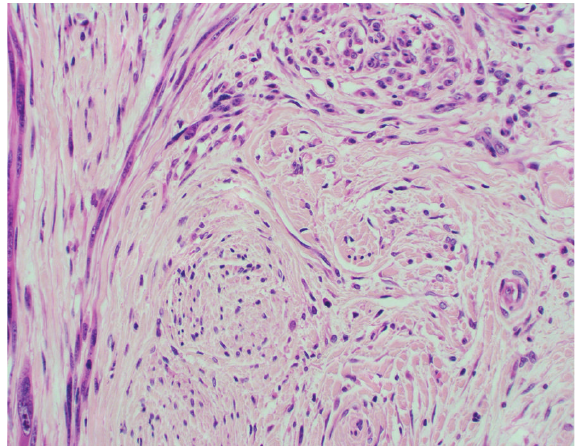
Figure 3: High power ( × 400) view of a nodule shows a nerve (bottom half) surrounded by melanoma (darker spindle cells on the left and top). The tumour cells at the top of the picture are arranged in a fasciculated (bundled) growth pattern, similar to the nerve next to